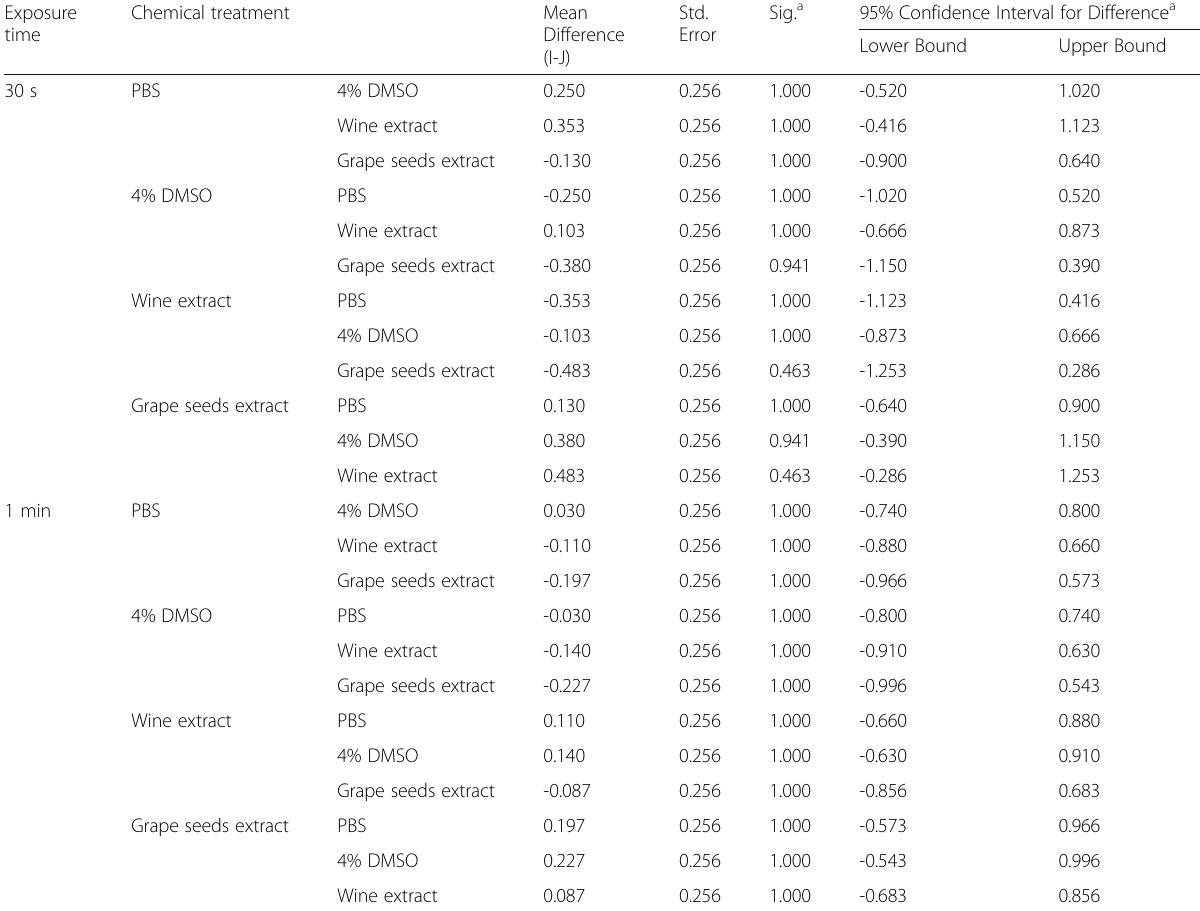
Based on estimated marginal means a Adjustment for multiple comparisons: